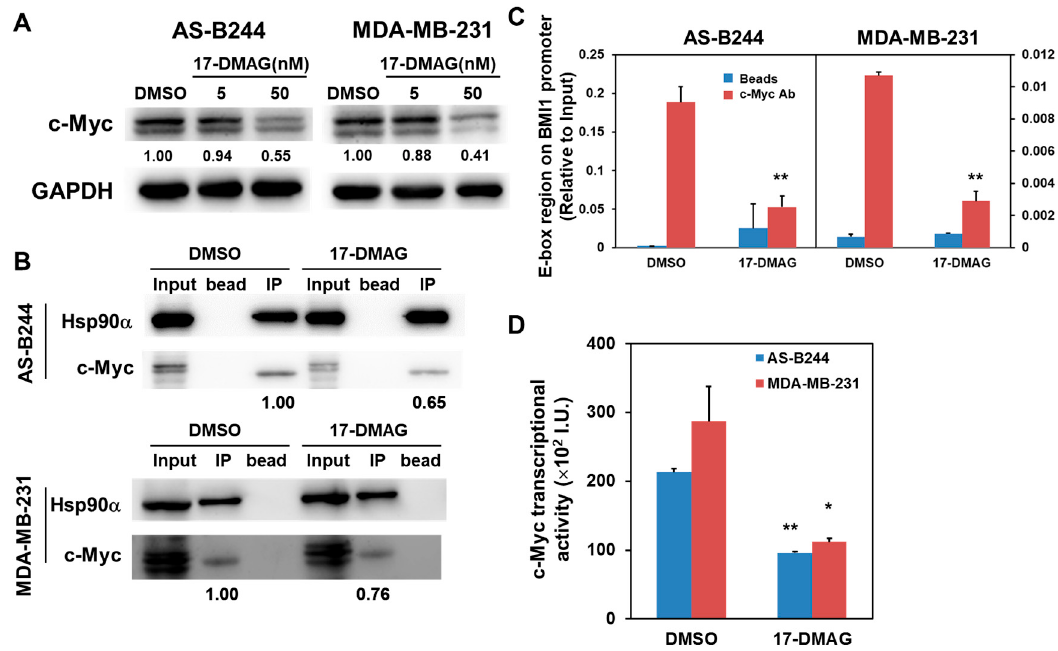
Figure 3. The transcriptional activity of c-Myc in TNBC mammospheres was suppressed by 17-DMAG. The mammospheres were cultured from AS-B244 or MDA-MB-231 TNBC cells for 96 h under the treatment of 0.1% DMSO or 17-DMAG (5 or 50 nM in ( A ) and 50 nM for ( B ). The protein expression of c-Myc was determined by Western blot ( A ) and the interaction between c-Myc and Hsp90 α was determined by immunoprecipitation of anti-Hsp90 α antidody ( B ). The binding of c-Myc to the E-box (-CACGTG-) region of the BMI1 promoter was determined by chromatin immunoprecipitation with anti-c-Myc antibody and the qPCR method. Data were presented as the relative expression level to the input chromatin of each sample ( C ). Transcriptional activity of c-Myc in TNBC mammospheres under 50nM 17-DMAG treatment was determined with a luciferase-based reporter assay ( D ). * p < 0.05; ** p < 0.01.